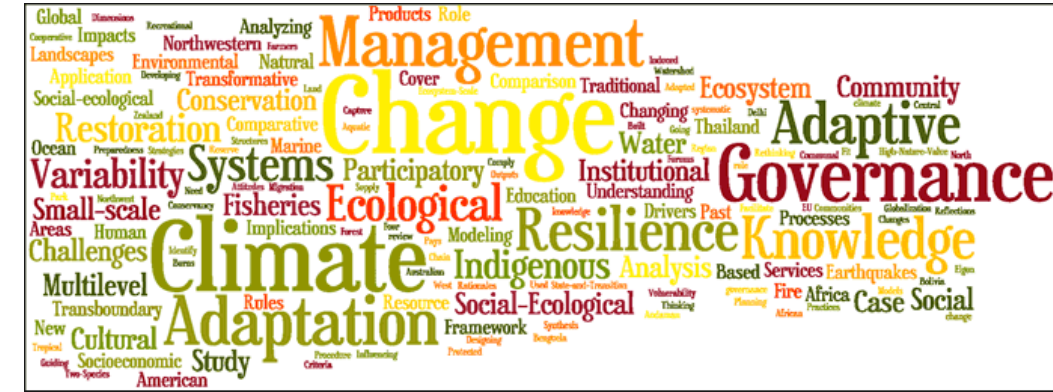
Fig. 1. Word cloud of article titles in Issues 3 and 4 of Volume 18 of Ecology and Society